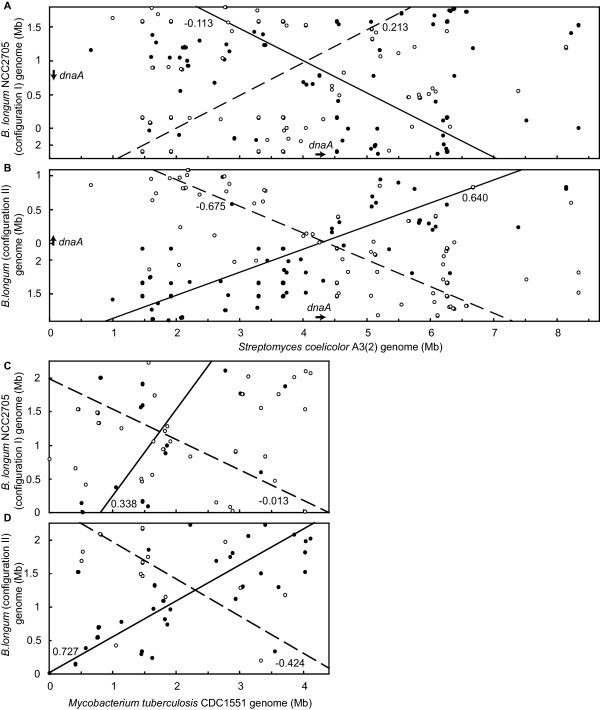
Between-species comparisons of the two chromosomal configurations of Bifidobacterium longum NCC2705 and of related species. Relative positions of homologous segments on sequences of configurations I (A, C) and II (B, D) of B. longum NCC2705 against S. coelicolor A3(2) (A, B) and M. tuberculosis CDC1551 (C, D). Full circles and open circles indicate pairs of homologous DNA segments that have the same, respectively the opposite orientation on the chromosome. Since the S. coelicolor A3(2) genome is linear, its origin of replication cannot be placed at position 1. Therefore, in A and B, both configurations of the B. longum genome are linearized by placing the terminus of replication at the origin of the graph. For B. longum NCC2705 in configuration I (A), the probable terminus of replication of the integrated plasmid has been chosen as the terminus of replication and placed at the origin of the graph. For the B. longum in configuration II, the maximum of the first codon position cumulative GC skew has been chosen as the terminus. On (A) and (B), position and orientation of the dnaA gene on each genome is indicated by a thick arrow. Lines represent type II regressions of direct (full line) and of indirect hits (dashed line). For each regression, the corresponding correlation coefficient is indicated.